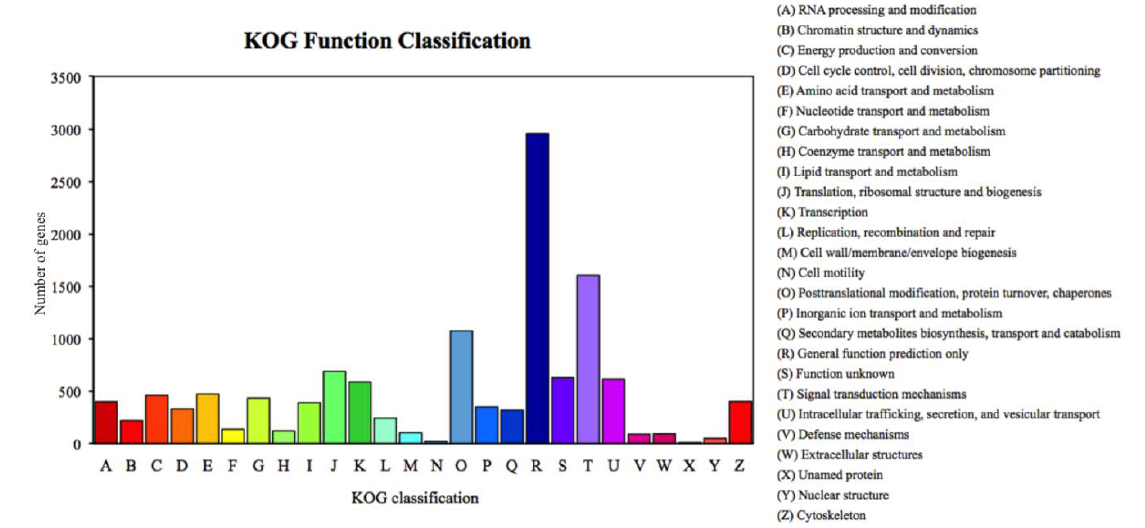
Figure 2. Percent of Romalea microptera ’s unigenes in each functional category for expressivity and dominancy, explained and classified by the Keeper of the Grove (KOG) database.